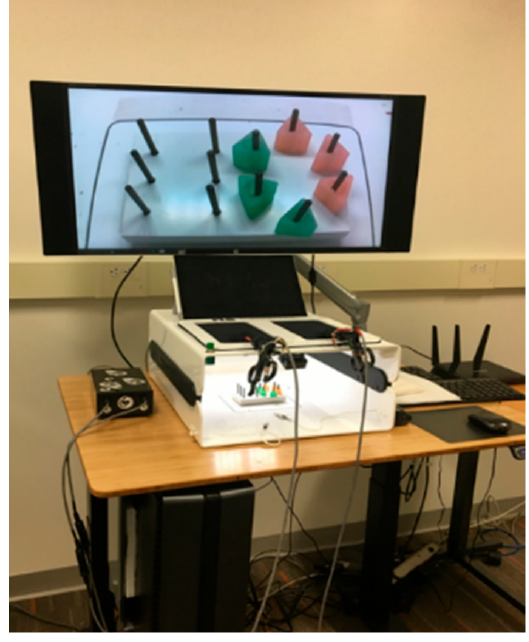
Figure 9. The IBTS.